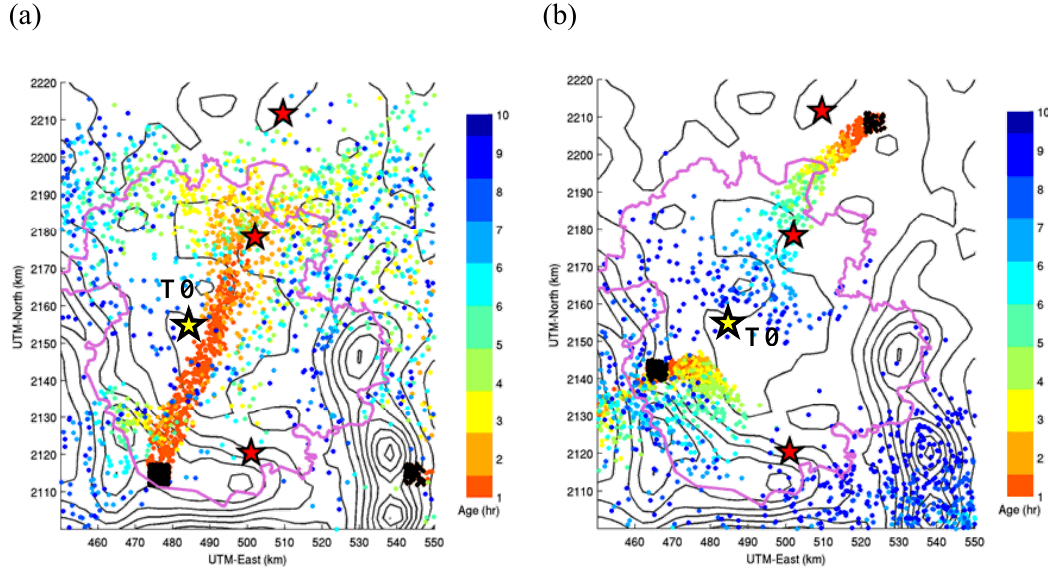
Fig. 2. Modeled fire impact over MCMA with FLEXPART forward trajectories during (a) the evening of 20 March (18:00–19:00CST) and (b) the early morning of 21 March (04:00–05:00CST). Stars represent Santa Ana, T0, T1, T2, from South to North, with T0 in yellow. Black squares represent the